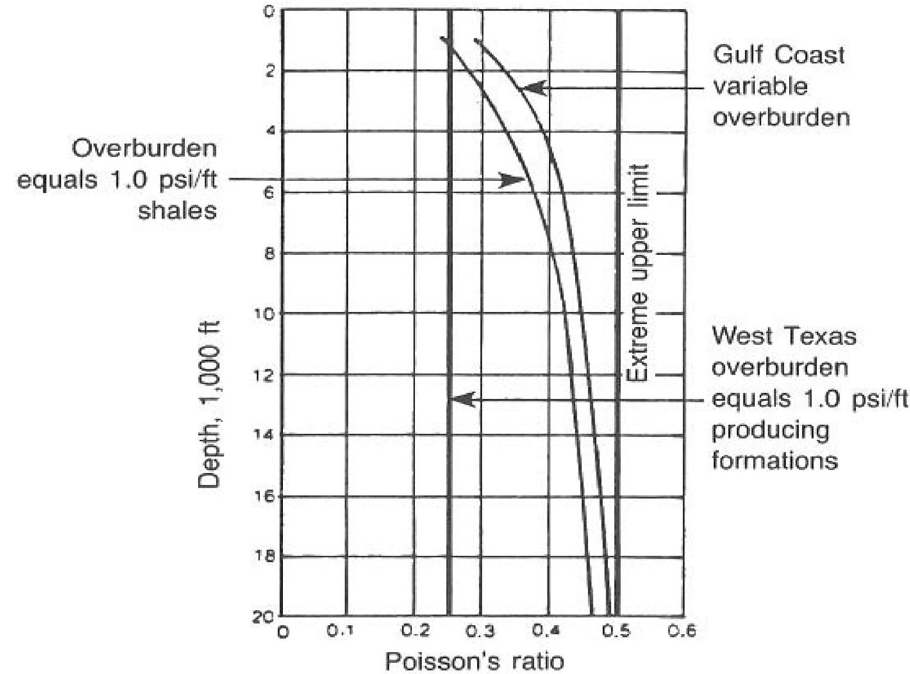
Fig. 6 Variable Poisson’s ratio with depth as proposed by Eaton